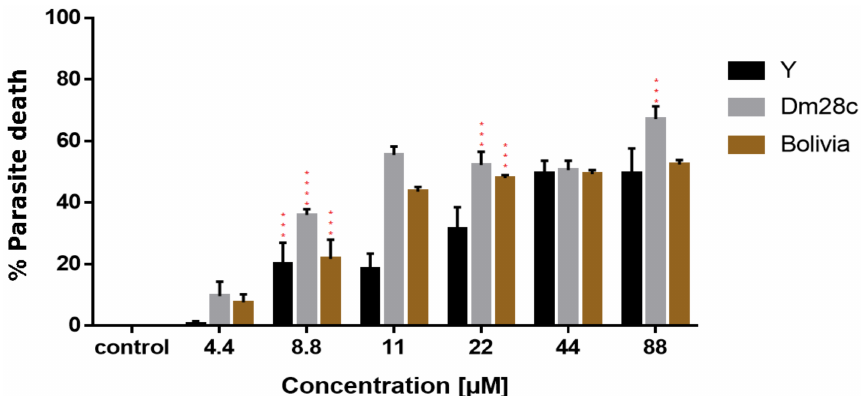
Figure 6. Trypanocidal activity of DETC nanoparticles against different strains of Trypanosoma cruzi . The parasites were exposed to different concentrations of DETC-loaded nanoparticles (4.4 µ M to 88 µ M) for 24 h. Results are presented as mean ± standard deviation of the percentage of parasitic inhibition in an independent triplicate system and for the statistical analysis of the ANOVA test, together with Tukey’s post hoc test; p < 0.001 (***), p < 0.0001 (****). In order to verify differences, the profile of each strain was compared against others treated with the same concentration of DETC nanoparticles and the